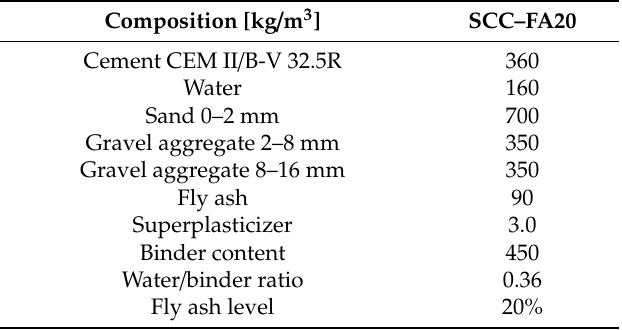
Table 1. Composition of self-compacting concrete (SCC)